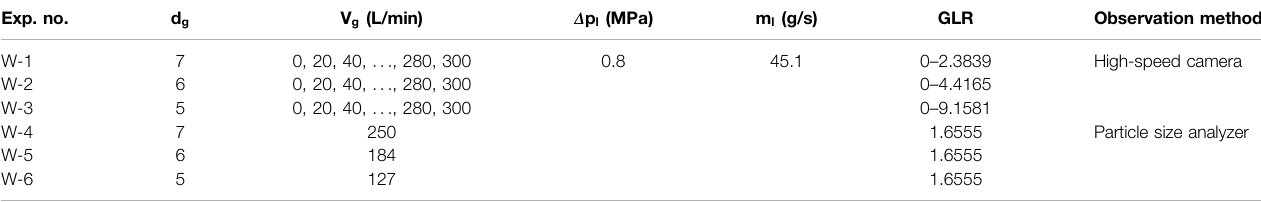
TABLE 3 | Working conditions of the liquid and gas injectors to study the gas core size impacts. Exp. no.